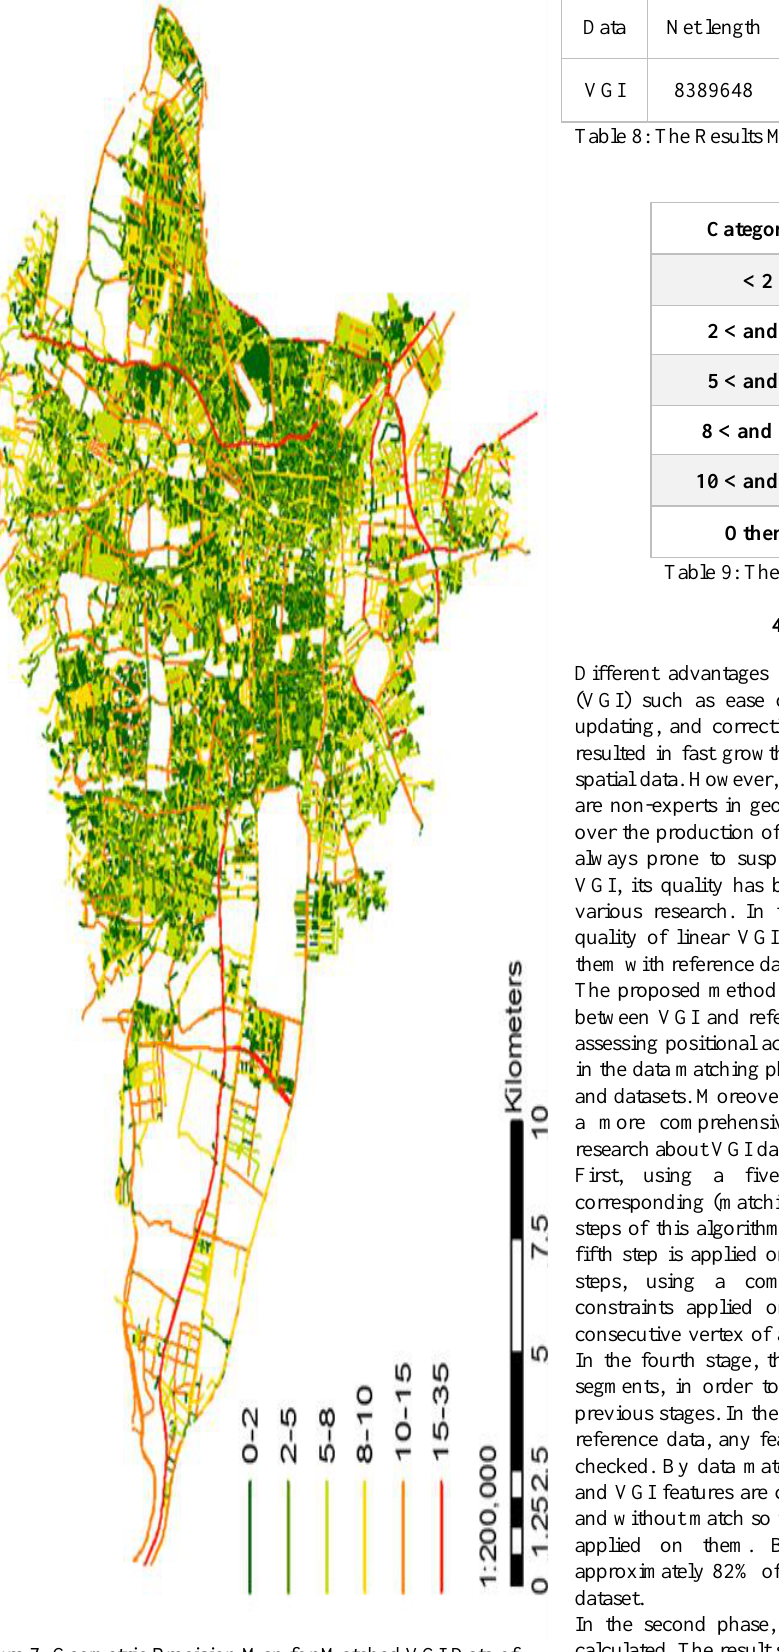
Figure 7: Geometric Precision Map for Matched VGI Data of